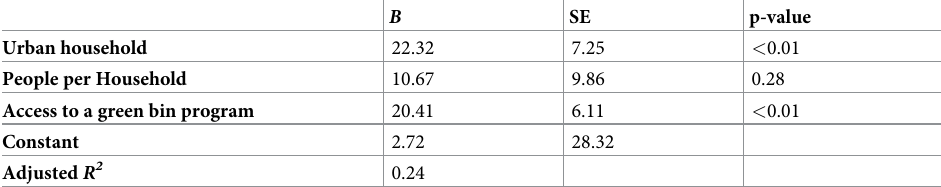
Table 4. Multiple regression on summer food waste disposal (kg/household/week).